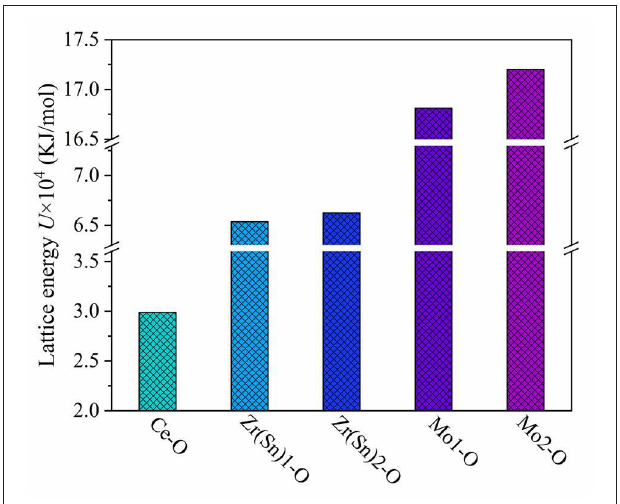
FIGURE 9 | Lattice energy for Ce 2 (Zr 0.94 Sn 0.06 ) 3 (MoO 4 ) 9 ceramics sintered at 800 ◦ C.